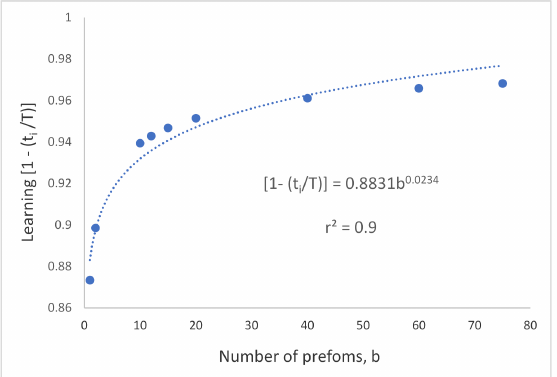
Figure 15. Learning as a function of manufacturing time and number of